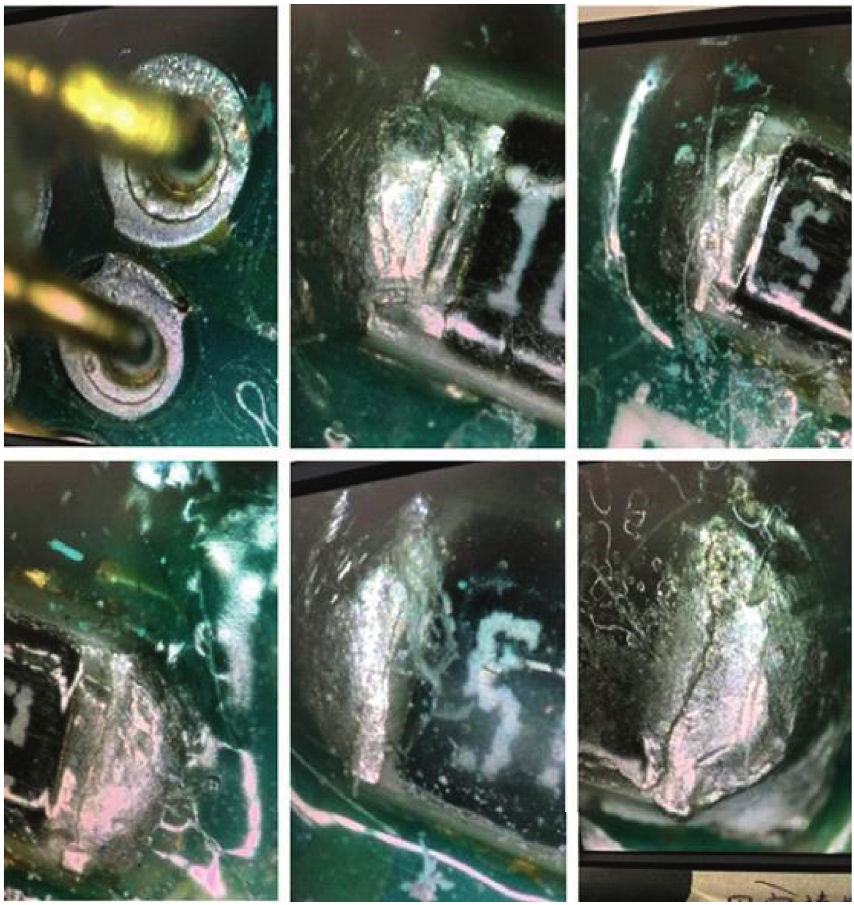
Figure 9: Macromorphology of the welding crack.